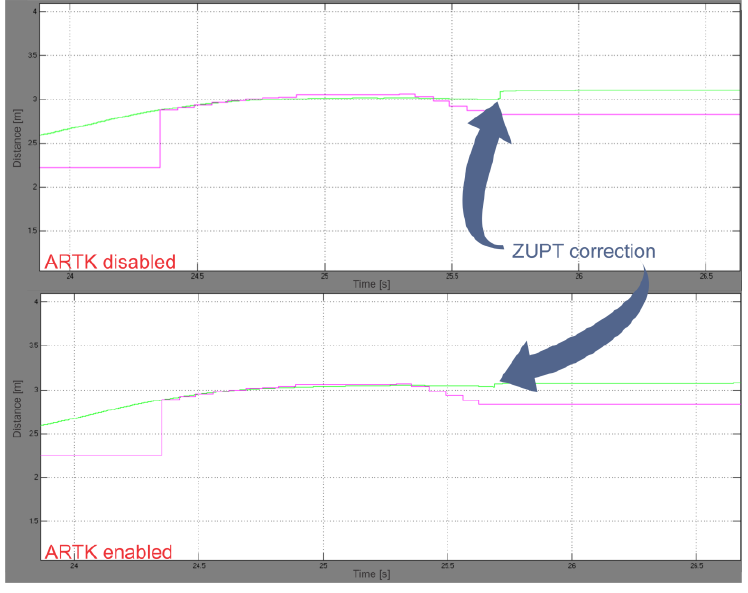
Figure 9. Close-ups of the two positional graphs obtained with the slow walking experimental data with ARTK mode disabled ( upper graph ) and ARTK mode enabled ( lower graph ). Sensible reduction in ZUPT-induced position correction is indicated by the